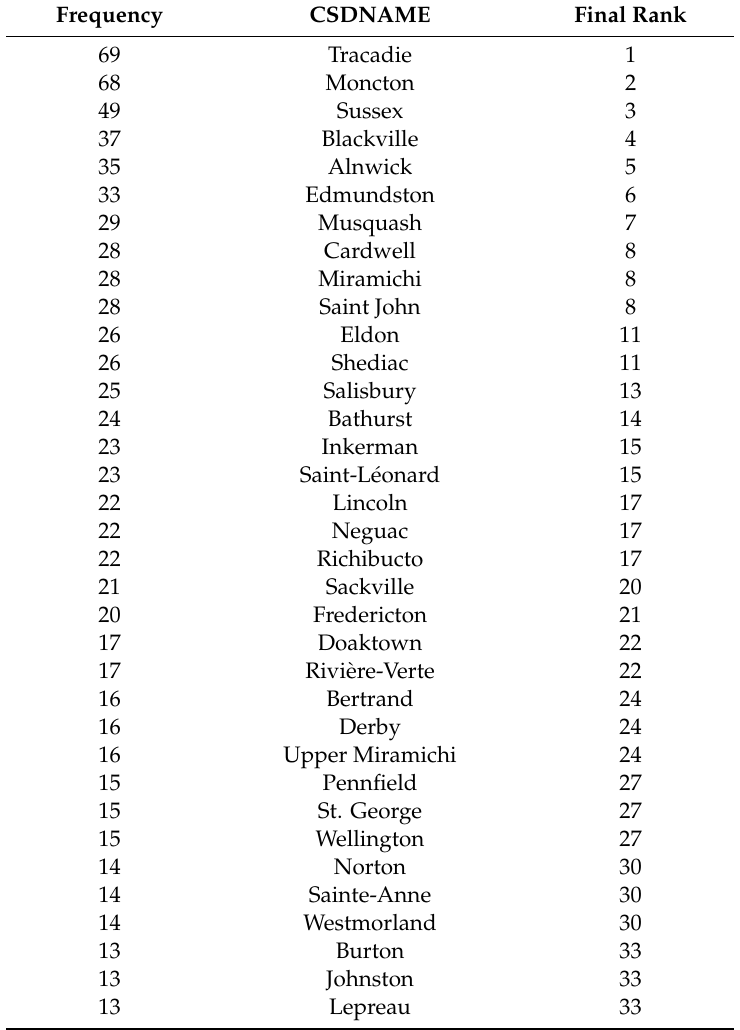
Table 8. Risk to damage from road and railway prioritization based on frequency analysis. Frequency CSDNAME Final Rank 69 Tracadie 1